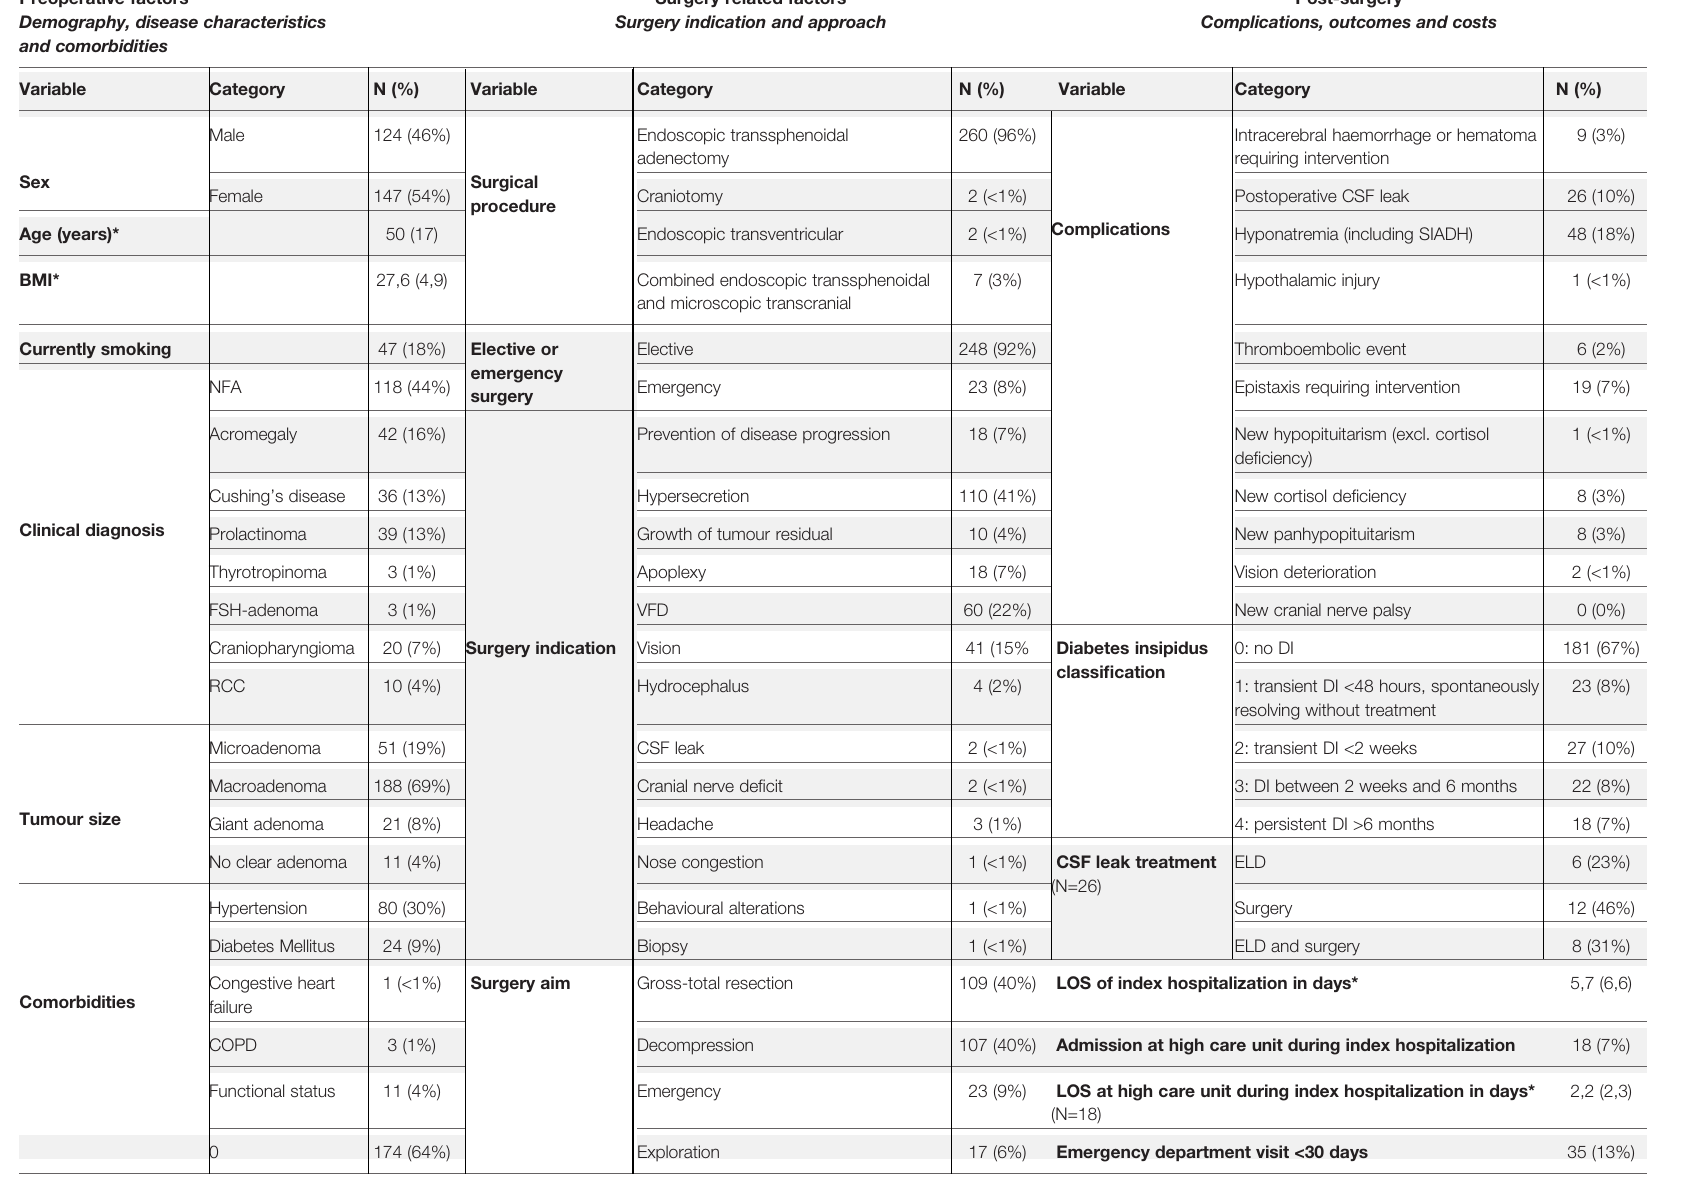
TABLE 1 | Baseline characteristics displayed in number of patients with corresponding percentage or mean with standard deviation. Preoperative factors Demography, disease